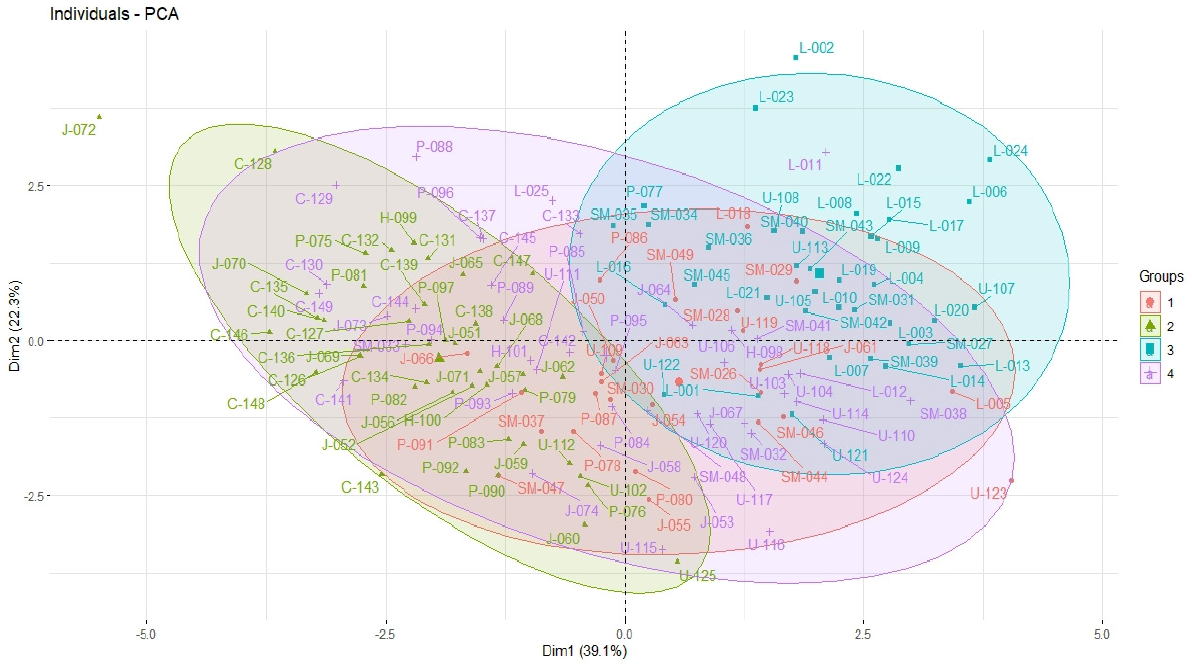
Figure 3. Distribution of the 149 achiote accessions along the two principal components. The different clusters (in graphic named groups) are indicated by a color and symbol (Cluster 1: red dot, Cluster 2: green triangle, Cluster 3: blue square, and Cluster 4: purple plus